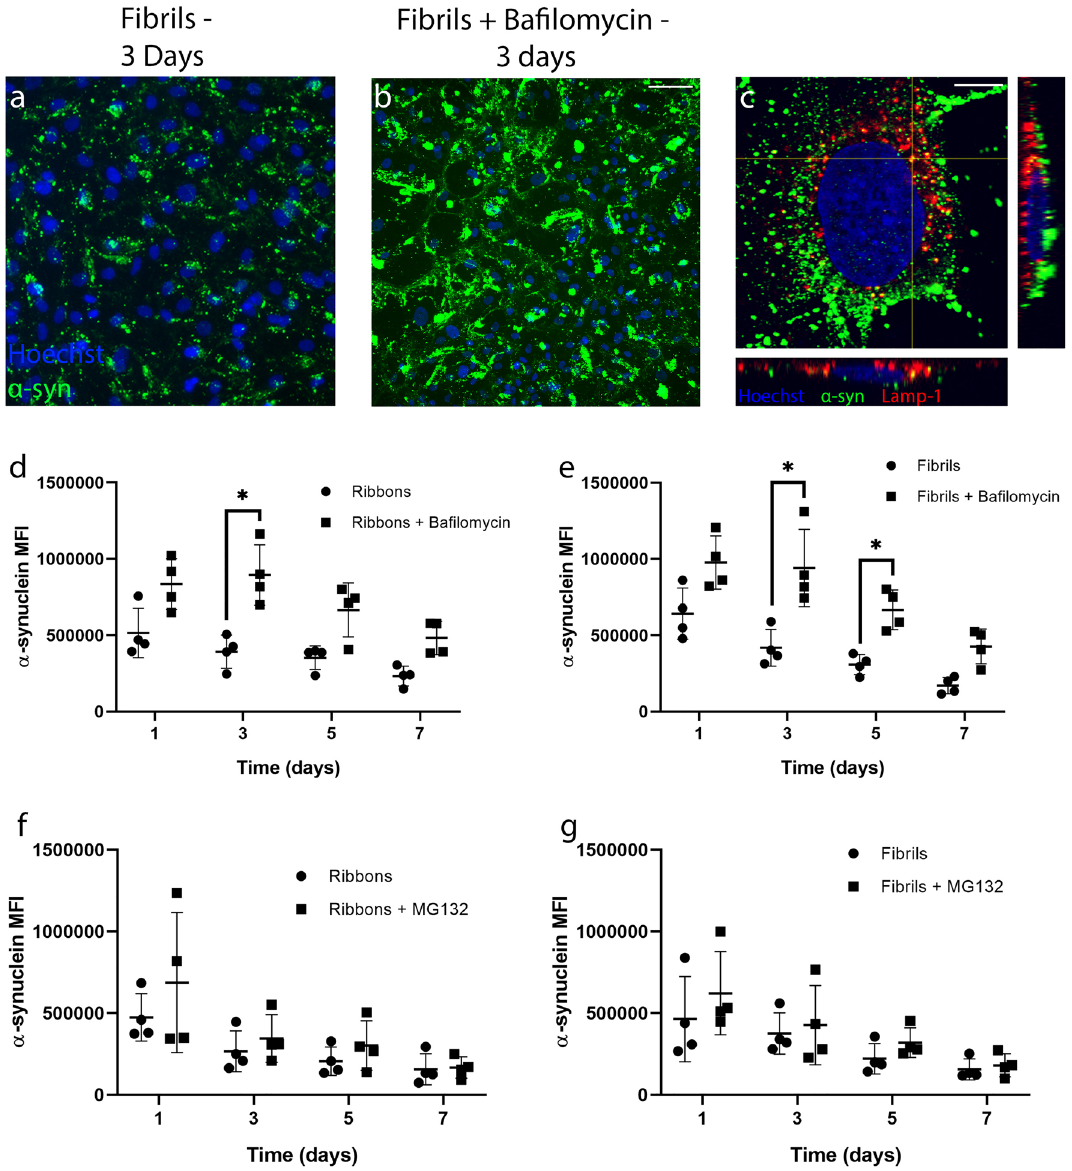
Figure 6. Mechanisms of degradation of α-syn in primary human brain pericytes. Pericytes were incubated with ( a ) α-syn alone for 3 days or ( b ) pre-treated with bafilomycin (200 nM). ( c ) Confocal microscopy with orthogonal views of α-syn co-localising with LAMP-1 vesicles. Scale bar = 10 µm. Pericytes were pre-treated with bafilomycin (200 nM) for 4–6 h prior to a 7 days incubation and MFI was measured using fixed flow cytometry for ( d ) ribbons (50 nM) or ( e ) fibrils (50 nM). Pericytes were pre-treated with MG132 (5 µM) for 6–8 h prior to a 7 days incubation and MFI was measured using fixed flow cytometry for ( f ) ribbons (50 nM) or ( g ) fibrils (50 nM). ( n = 4 in each group, mean ± SD). * p <